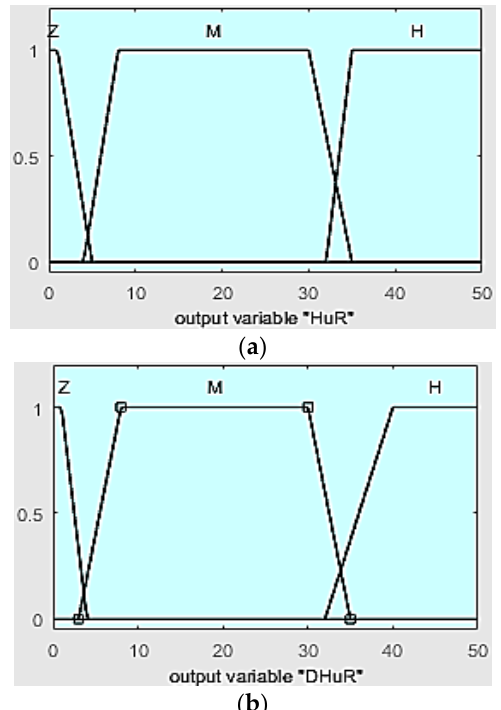
Figure 13. Membership functions of the output variables: ( a ) the humidification rate HuR ( b ) and the dehumidification rate DHuR.